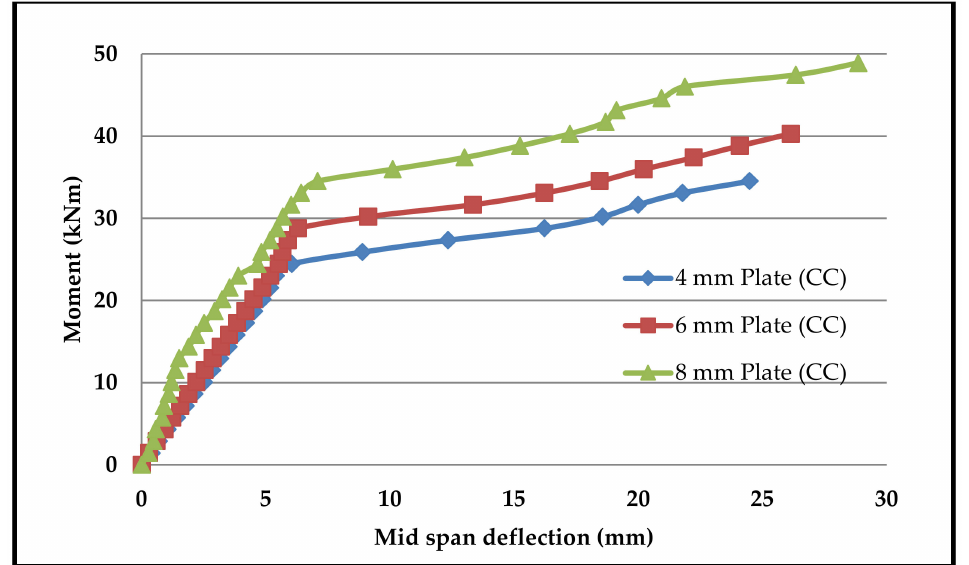
Figure 15. Moment–deflection curve for SCS beams used with conventional concrete (CC)